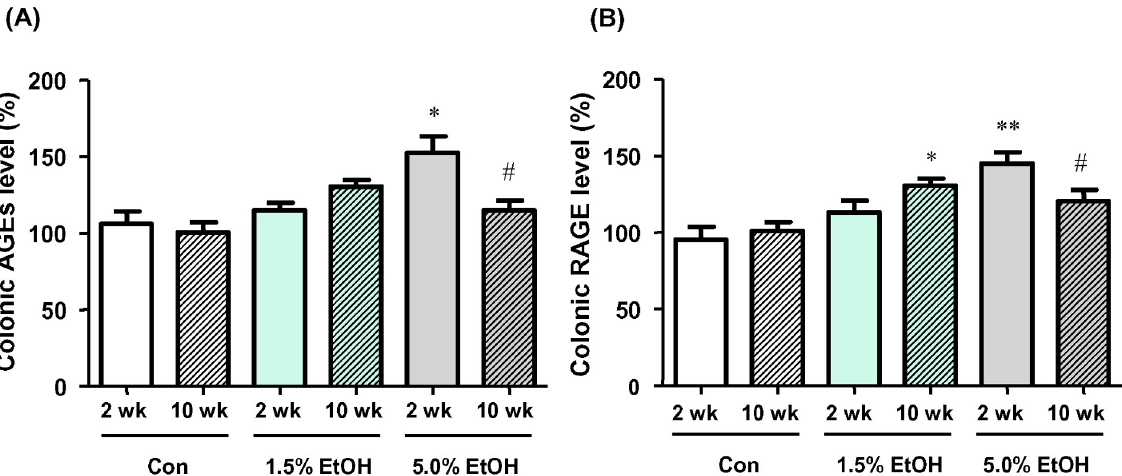
Fig 6. Effects of chronic oral administration of ethanol on AGEs and RAGE levels in colonic tissues in mice. (A) Relative percentages of the AGEs levels, as quantified by ELISA, with the level obtained with a 2-wk Con subject taken to be 100%. (B) Relative percentages of RAGE levels, as quantified by means of ELISA, are shown with the level obtained with a 2-wk Con subject taken to be 100%. Results are means ± SD (n = 5). � p < 0.05, �� p < 0.01 versus 2 wk Con, as assessed by ANOVA with the Tukey-Kramer test. # p < 0.05 for 2 wk versus 10 wk with the same ethanol dosage, as assessed by the paired t -test. For abbreviations for ethanol-administration conditions, see the legend to Fig 2.